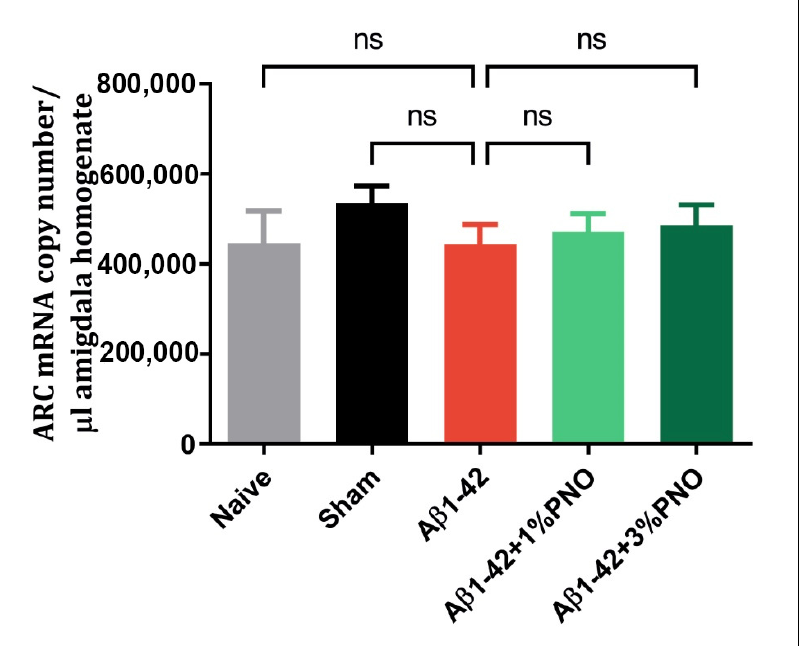
Figure 4. Effects of the inhaled Pinus halepensis essential oil (PNO, 1%, and 3%) on the ARC mRNA copy number determined in the rat amygdala homogenates of the A β 1-42-treated rats. Values are means ± S.E.M. ( n = 5); ns: non-significant.